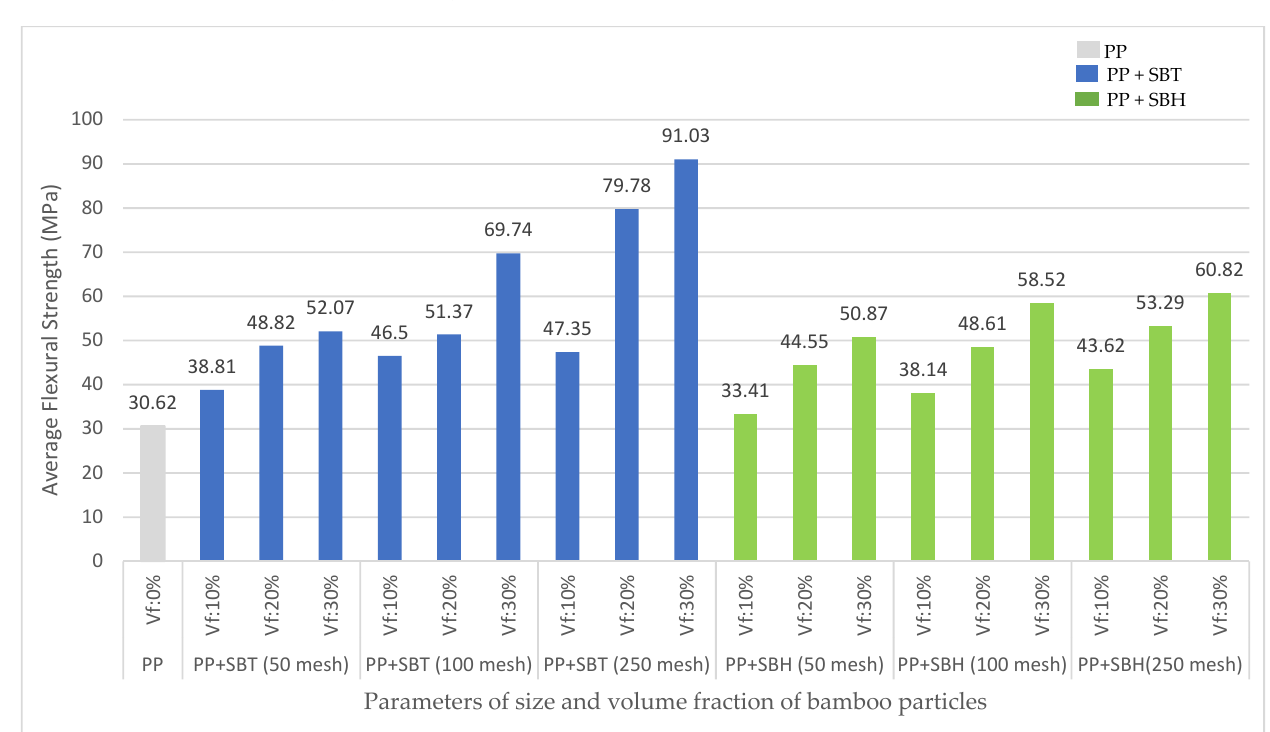
Figure 4. Relationship between PP composite flexural strength to volume fraction and particle size of SBT and SBH.